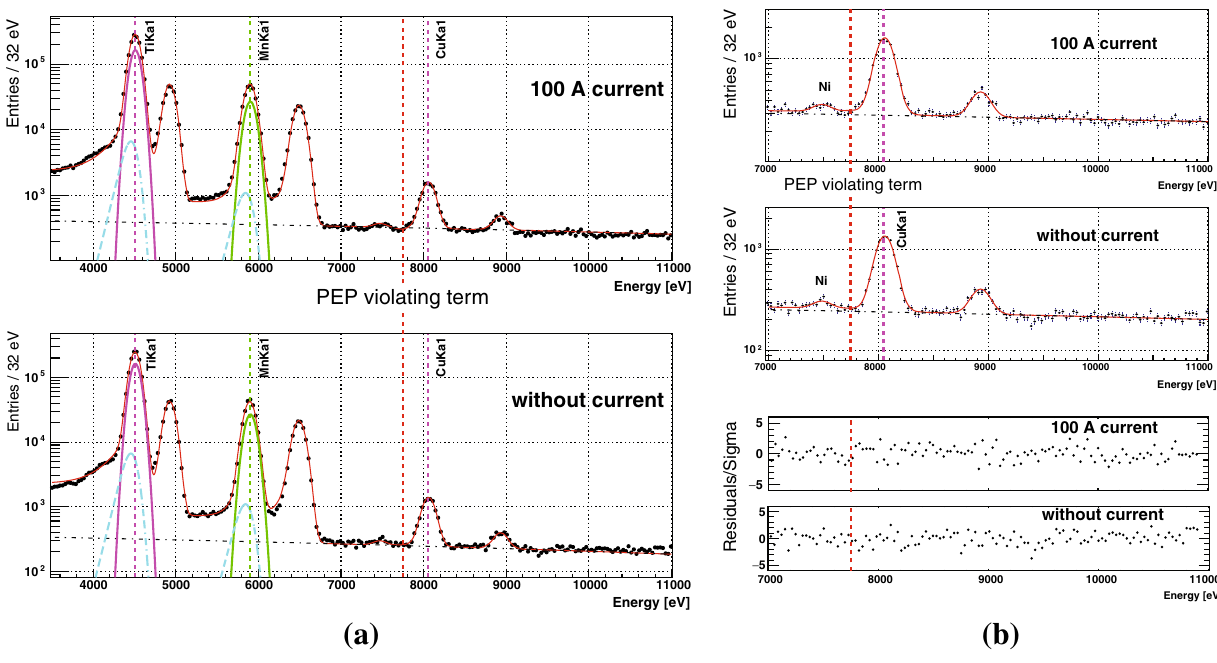
from the fit result are also plotted. a The fit to the wide energy range from 3 . 5 keV to 11 keV, b the fit and its residual for the 7–11 keV range where there is no background coming from the calibration source. See the main text for details